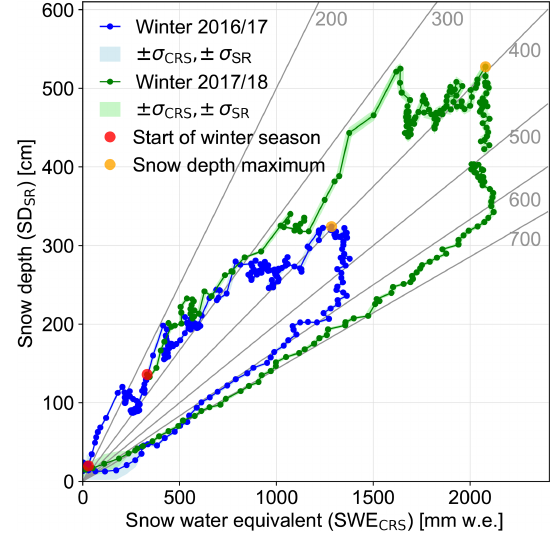
Figure 5. Daily mean SWE and daily mean SD. Grey lines show the densities in kilograms per cubic meter. The beginning of each winter season is marked by the red dot, and yellow dots indicate the seasonal maximum of